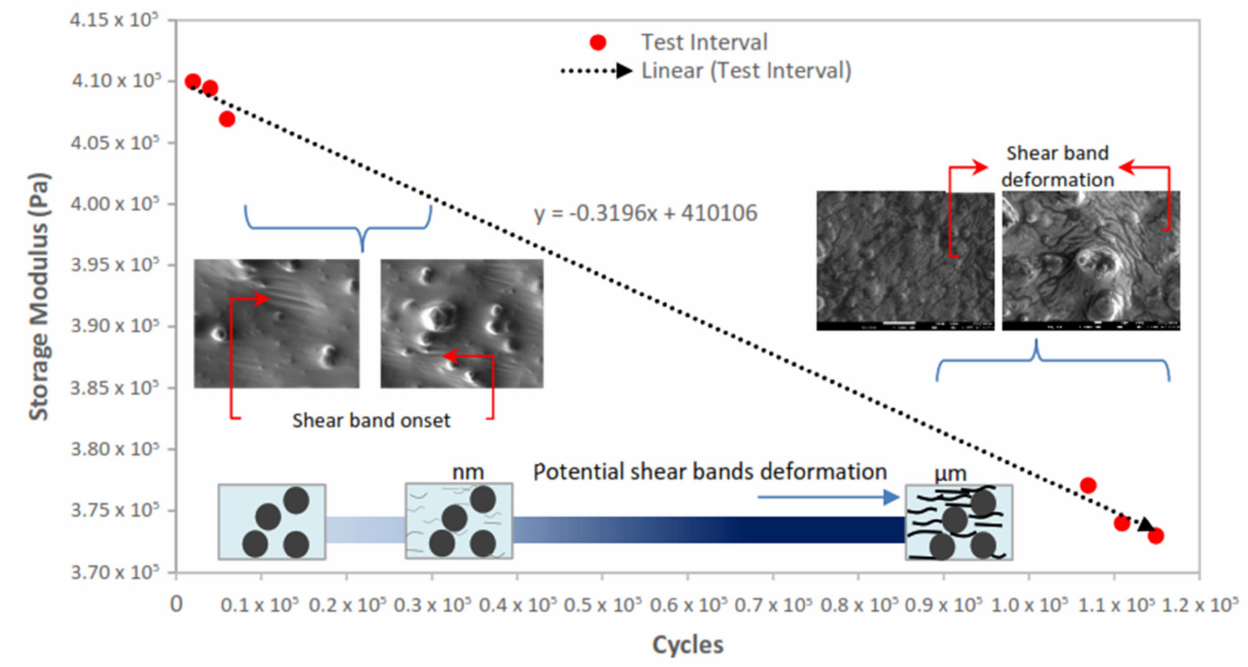
Figure 1. Storage modulus performance at the cycle-to-cycle fluctuation of oscillation shear stress for overall test cycles of stress relaxation. The supplemented linear correlation trendline led to the visual pattern spotting, nevertheless not completely representing the behavior. The left and right inserts display the FESEM image of shear band onset and deformation, respectively, at y = − 0.3196 x + 410,106 transition. The lower insert indicates the potential size deformation of the shear band corresponding to the length of the test